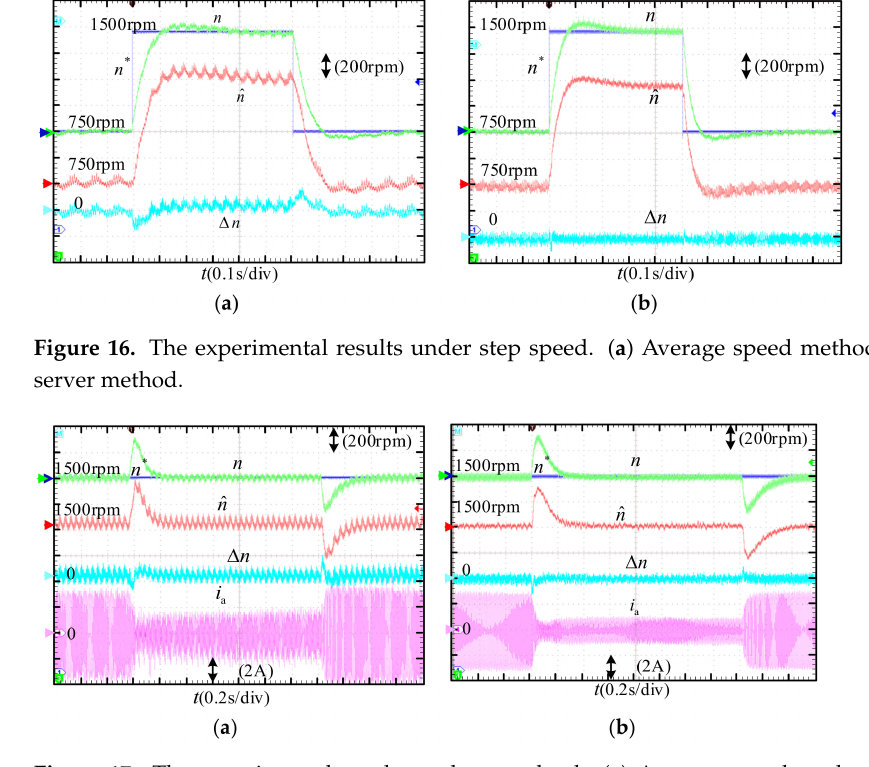
Figure 17. The experimental results under step load. ( a ) Average speed method; ( b ) Dual ob- server